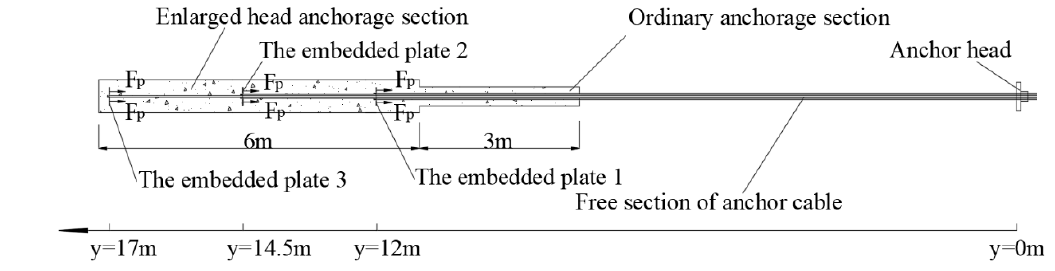
Figure 5. The enlarged head pressure-dispersed anchor cable sample diagram. Table 1. Material parameters .